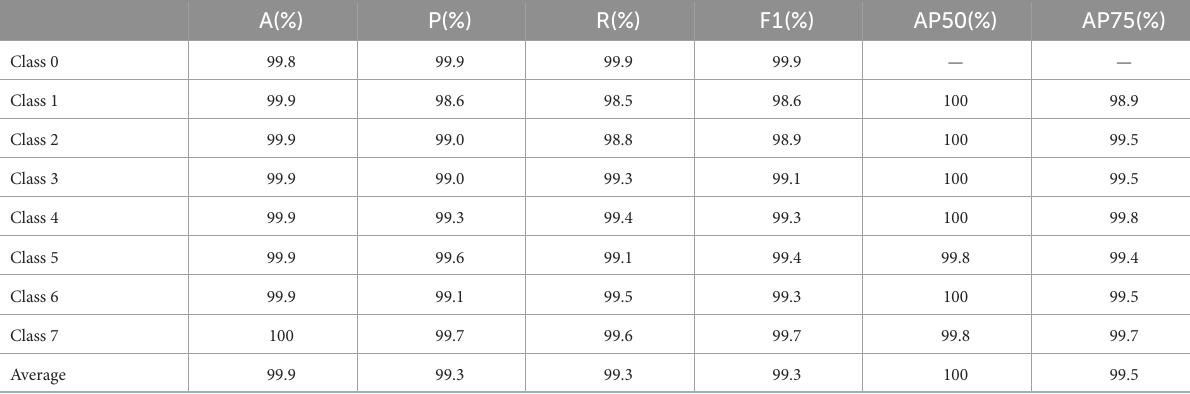
TABLE 1 Point-wise approach: Accuracy, precision, recall and F1 score metrics are reported for all the multiplet classes; the last row shows the average performance over the